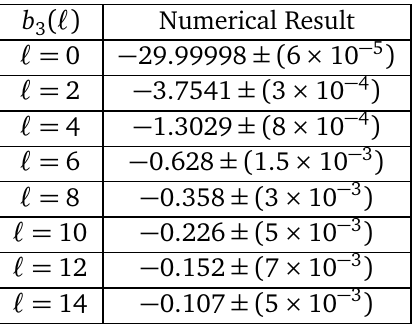
Table 2: Numerical results for the averaged corrections to the three-point functions of the twist four operators at order g 3